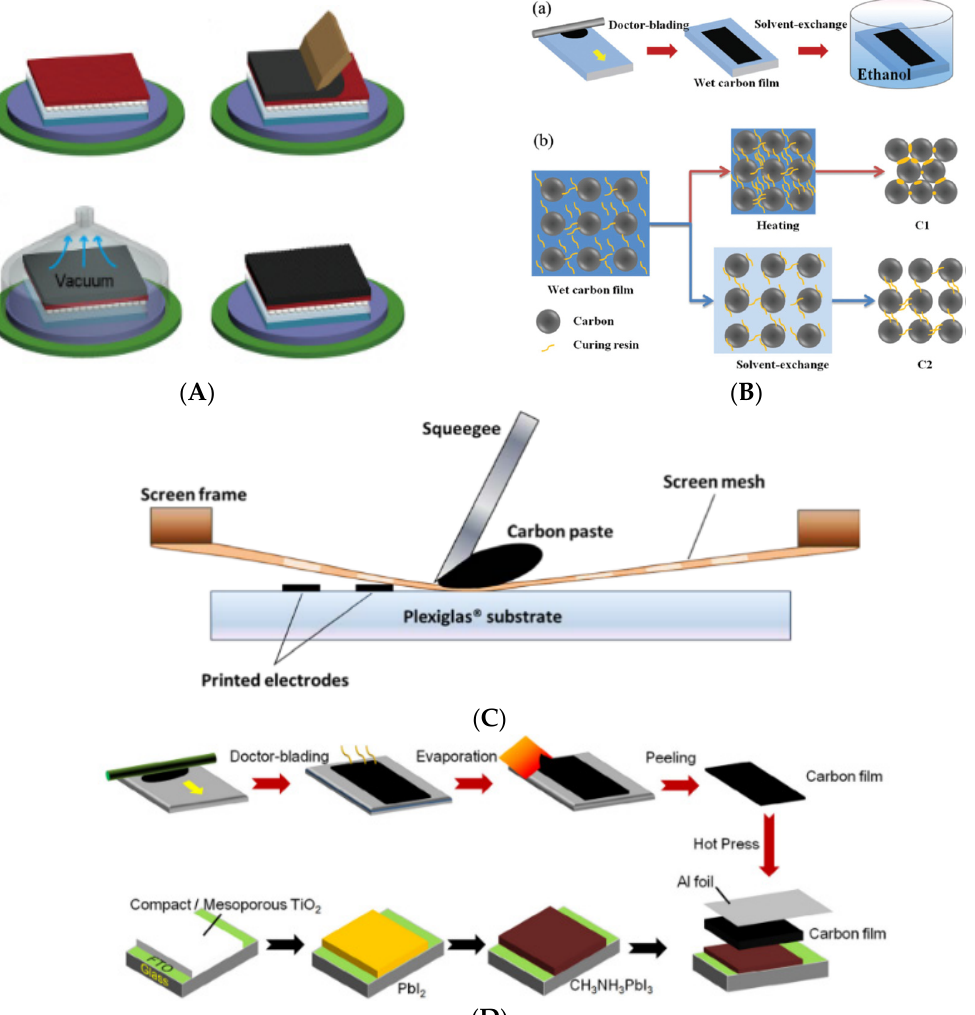
Figure 4. ( A ) Blade-coating deposition of carbon material and vacuum/heat treatment for fast drying the film; ( B ) Solvent exchange used to obtain carbon film; ( C ) Schematic structure of carbon paste printing with screen-printing technique; ( D ) Mechanical peeling-off of carbon film and incorporation into the solar device. Figure 4A,B is reproduced from references [98,100], respectively. Figure 4C,D is reproduced from references [102,103], respectively.